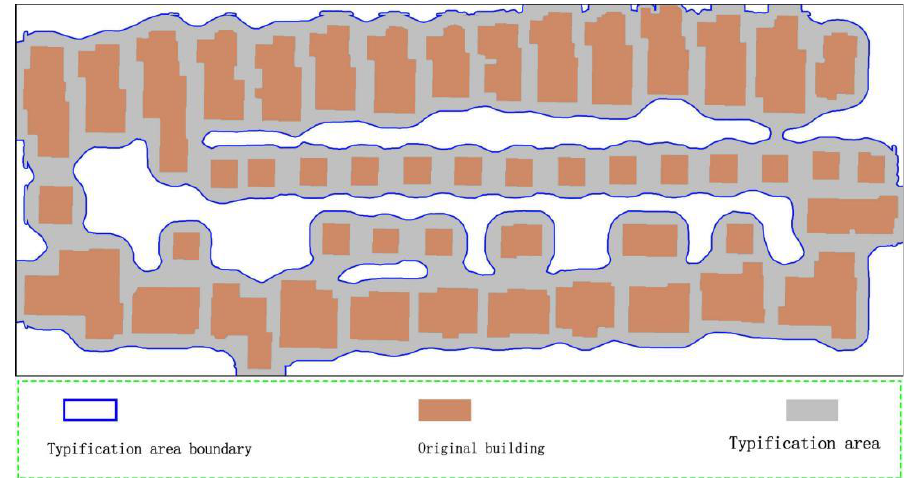
Figure 5. Construction of typification areas of buildings with the median filter.